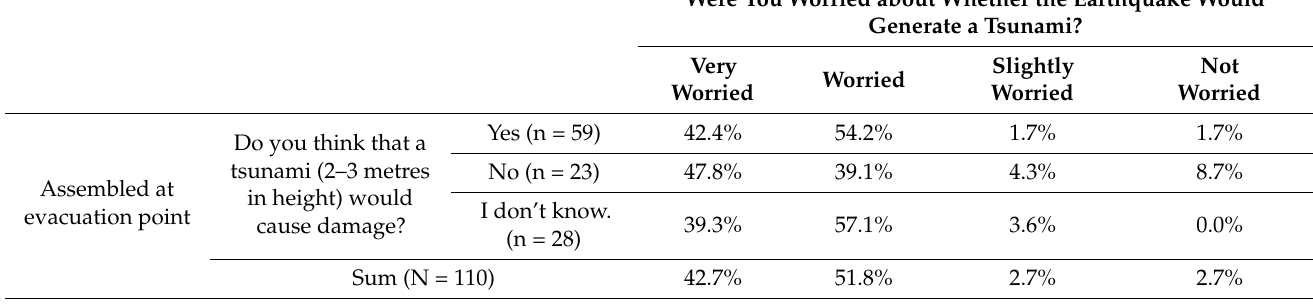
Table 4. Natech damage